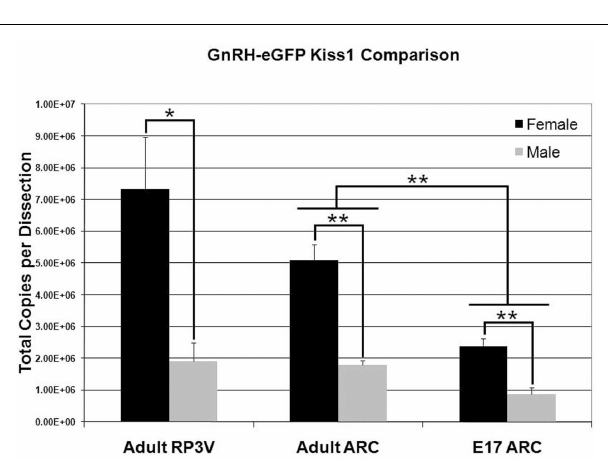
FIGURE 5 | Expression of Kiss1 in the RP3V . Digital images (left) of coronal sections show that Kiss1 in the RP3V was first detected at P12. A dramatic sex difference in the number of cells expressing Kiss1 was evident around